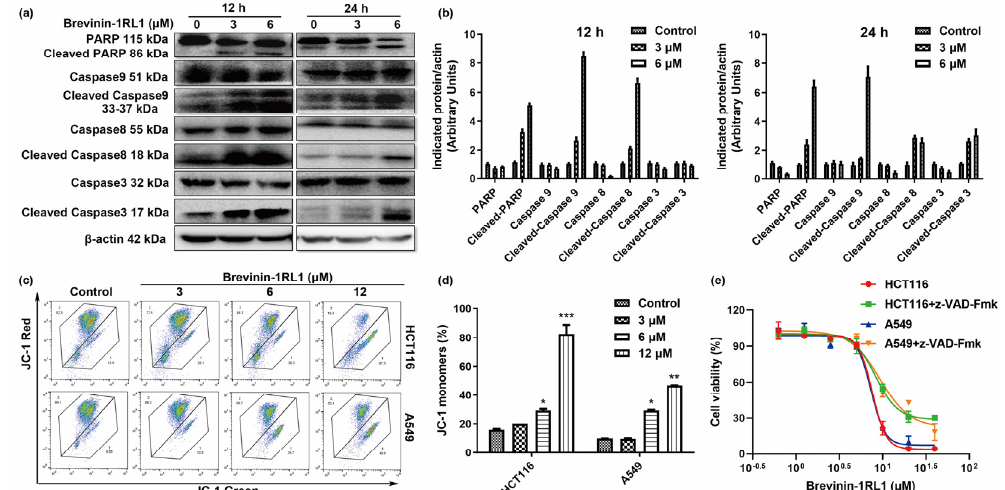
Figure 4. Brevinin-1RL1 induced cell apoptosis is caspase dependent. ( a ) HCT116 cells were incubated with Brevinin-1RL1 for 12 h or 24 h. Cell lysis extracts were analyzed by immunoblotting to detect the cleaved activation of caspase (caspase 3, 8, 9) and its substrates PARP. ( b ) Software Image J 1.52v (National Institutes of Health, Bethesda, USA) was used to gray value of caspase family proteins. ( c ) Effect of Brevinin-1RL1 on mitochondrial membrane potential. HCT116 and A549 cells were treated with different concentrations of Brevinin-1RL1 for 24 h and subjected to JC-1 stain dye and flow cytometry analysis. When the mitochondrial membrane potential is high, JC-1 aggregates in the matrix of mitochondria to form polymer and shows red fluorescence. However, when the mitochondrial membrane potential is low, JC-1 cannot aggregate in the matrix of mitochondria. At this point, JC-1 is a monomer and shows green fluorescence. The gating of the population was determined according to the change of fluorescence. ( d ) Quantification of the amount of JC-1 monomers and JC-1 aggregates for ( c ). ( e ) The rescuing effect of pan-caspase inhibitor z-VAD-Fmk on Brevinin-1RL1-induced cell death. Cells were preincubated with pan-caspase inhibitor z-VAD-Fmk for 2 h, followed by different concentrations of Brevinin-1RL1 treated for 48 h. The cell viability of cells was determined by MTS assay. * p < 0.05, ** p < 0.01 and *** p < 0.001 in comparison to negative controls, and indicated the significant difference between the two groups for indicated comparison. Data expressed as the mean ± SD ( n = 3).